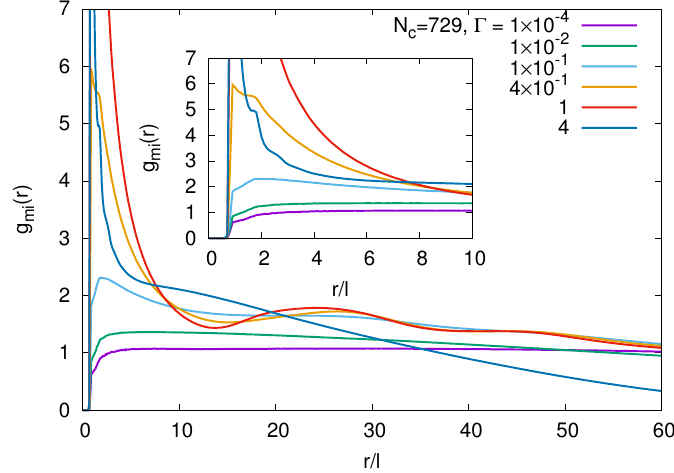
Figure 15. Monomer-counterion pair correlation functions for various interaction strengths Γ . The number of crosslinks is N c = 729, and the box size L / l = 400. The inset shows the correlation functions over a smaller range r / l